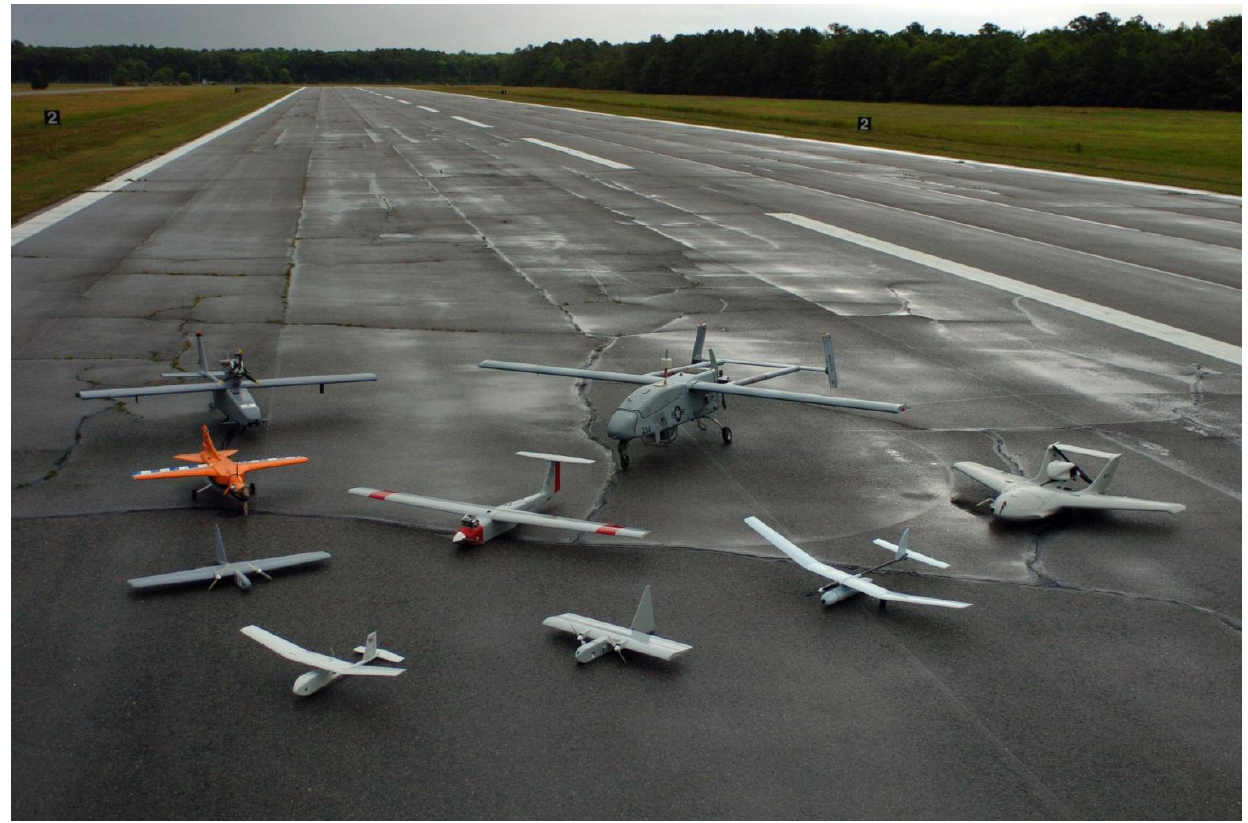
Figure 7. LASE and LALE UAS on display at 2005 Naval Unmanned Aerial Vehicle Air Demo. Pictured are (front to back, left to right) RQ-11A Raven, Evolution, Dragon Eye, NASA FLIC, Arcturus T-15, Skylark, Tern, RQ-2B Pioneer, and Neptune. Image Courtesy US Department of